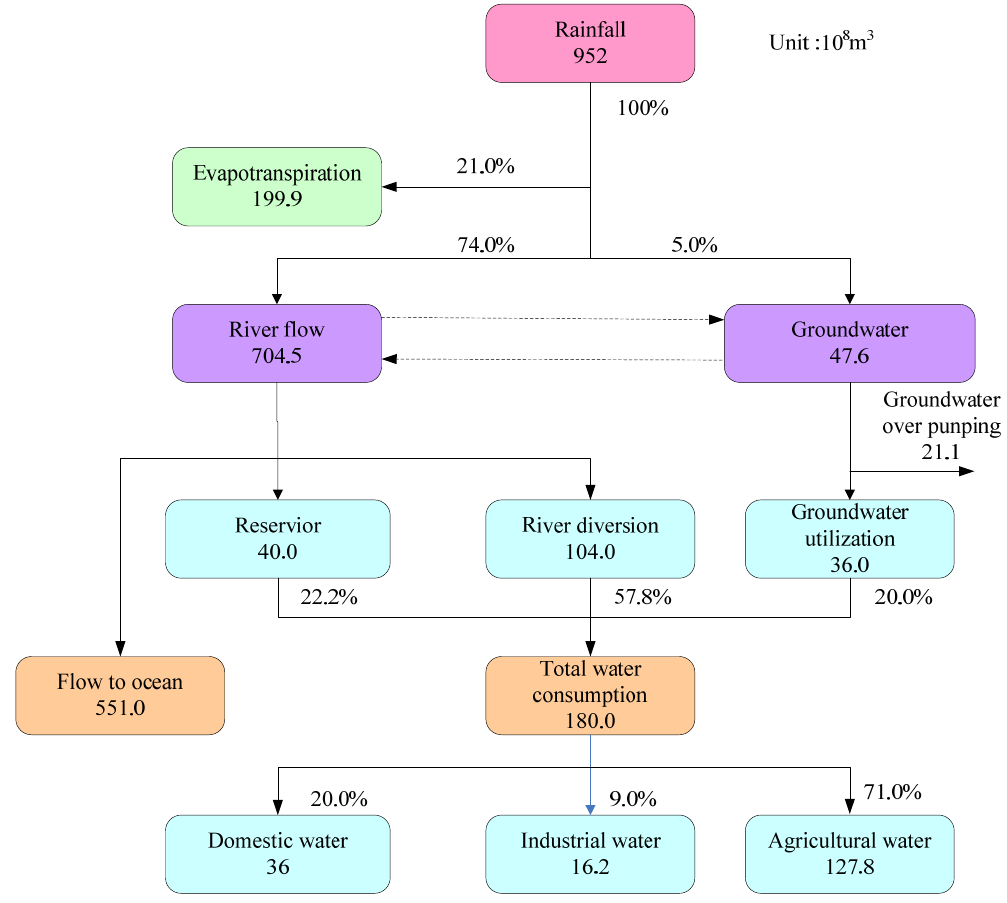
Figure 1. Schematic diagram of water balance in